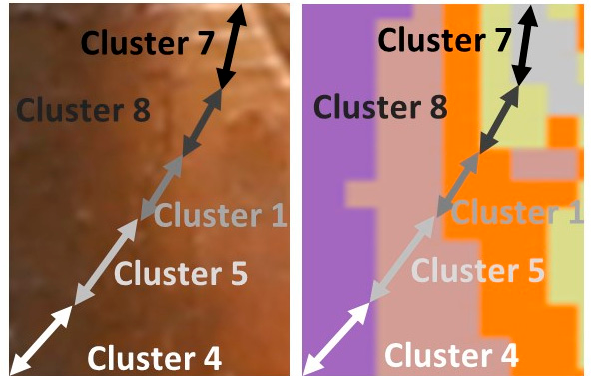
Figure 7. Left : Detail (macro photo) of Virgin Mary’s cheek where the multi-layered structure of the painting is evident. Right : Distribution of the various clusters that highlights the multi-layered structure of the painting.